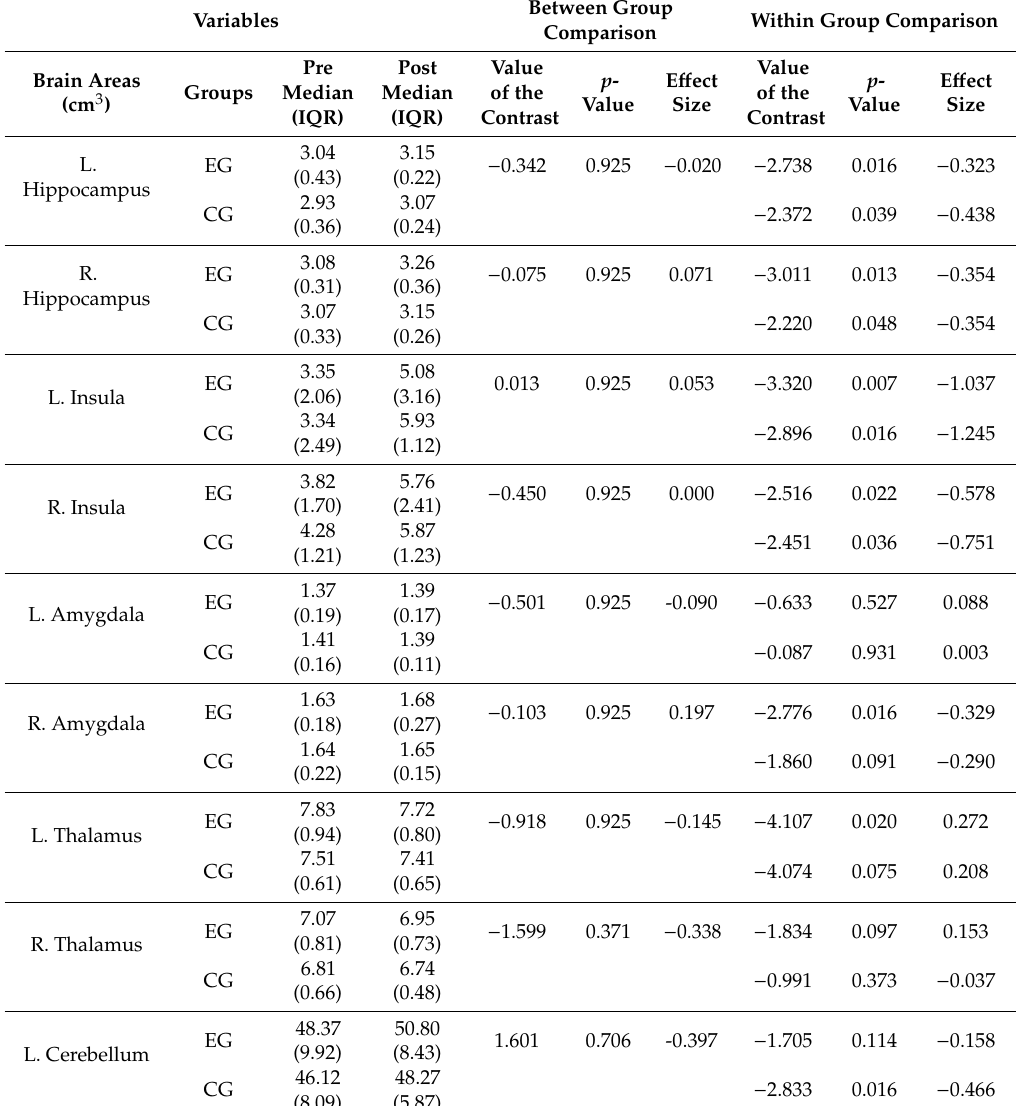
Table 2. E ffi cacy analysis of the e ff ects of exergame intervention in patients with fibromyalgia on the di ff erent brain structures, the pVO2, and the